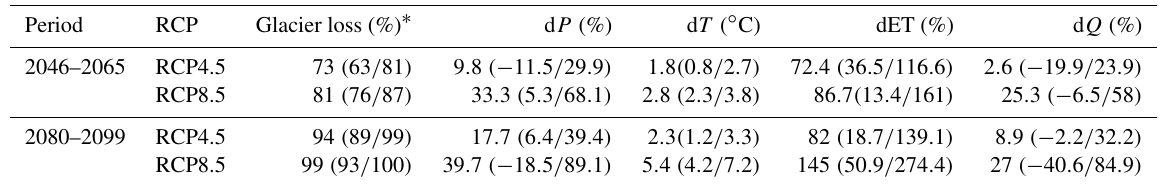
Figure 7. Monthly means and standard deviations of daily precipitation (a, b) and temperature (c, d) from observation (OBS), global climate models (GCMs) and bias-correction methods (LOCI and DBC) at Pandoh station during 1986–2005. Shading denotes the ensemble range of GCMs. Table 6. The projected changes in key water balance variables for 2046–2065 and 2080–2099 compared with 1986–2005 under RCP4.5 and RCP8.5 over the upper Beas